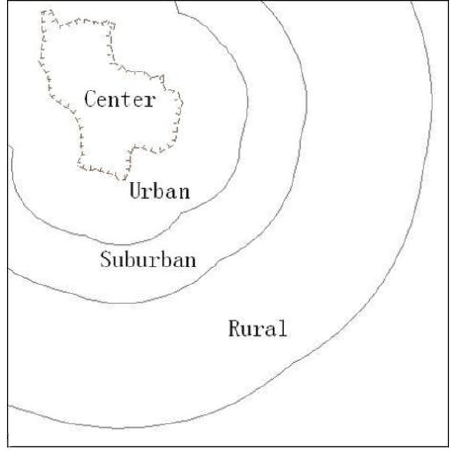
Figure 1. Map of urban, suburban and rural regions